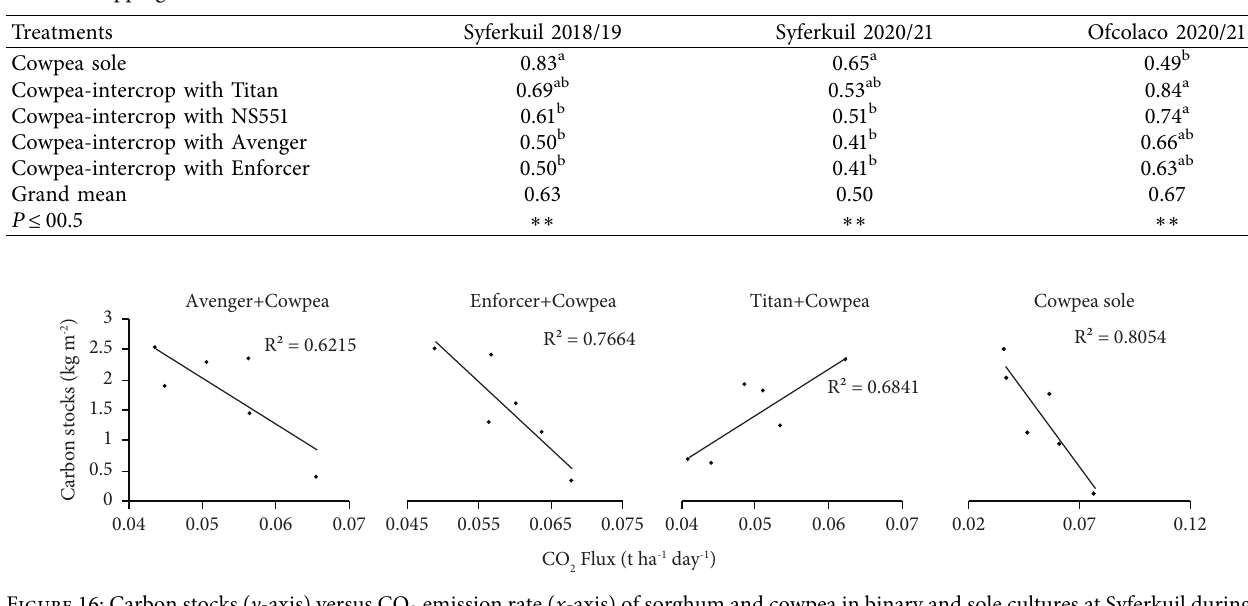
Table 4: Carbon dioxide emission efciency (CEE) of cowpea in intercrop and sole systems at Syferkuil and Ofcolaco during the 2018/19 and 2020/21 cropping seasons.